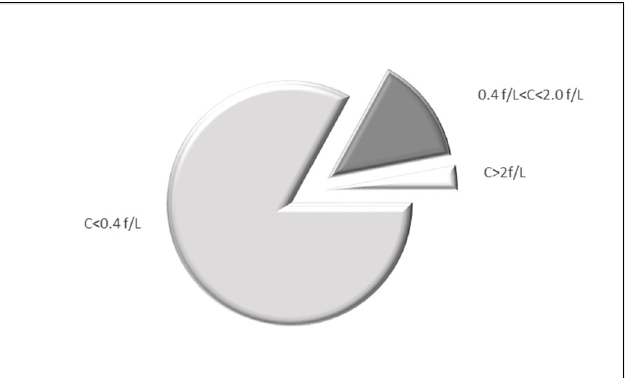
Figure 5. Maximum concentration of airborne asbestos fibers measured in public buildings with non-friable ACMs.